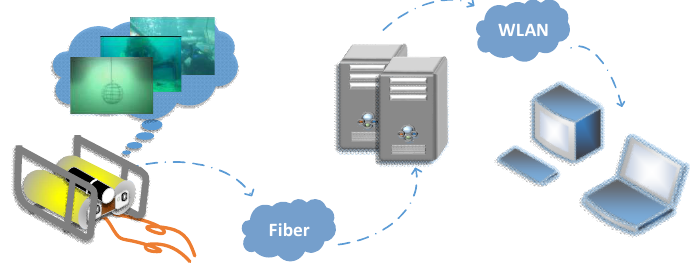
Figure 1. The Underwater Target Detection and 3D Reconstruction System.